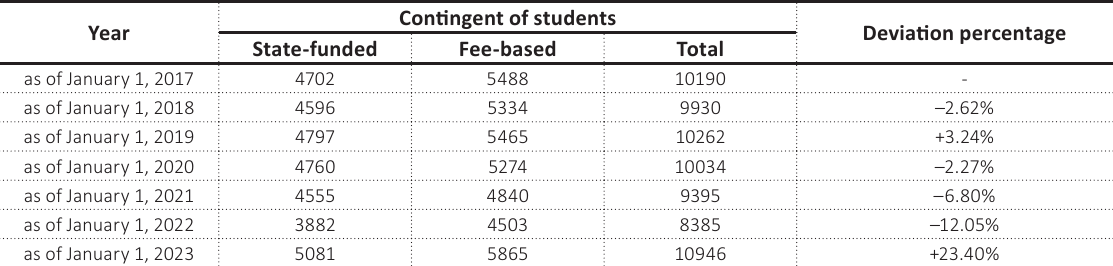
Table 2. Dynamics of increase in the number of